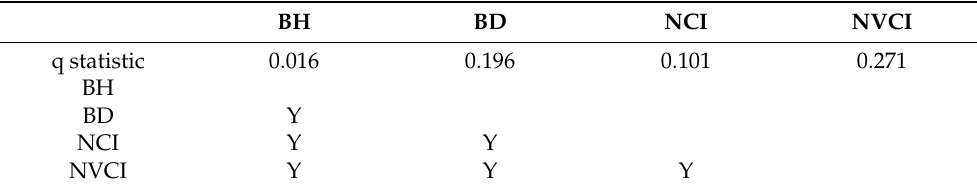
Figure 10. Relationship between heat accumulation and ( a ) NCI; ( b ) NVCI. Table 4. The influence power of urban morphology to heat accumulation and the significant test of the factor difference.